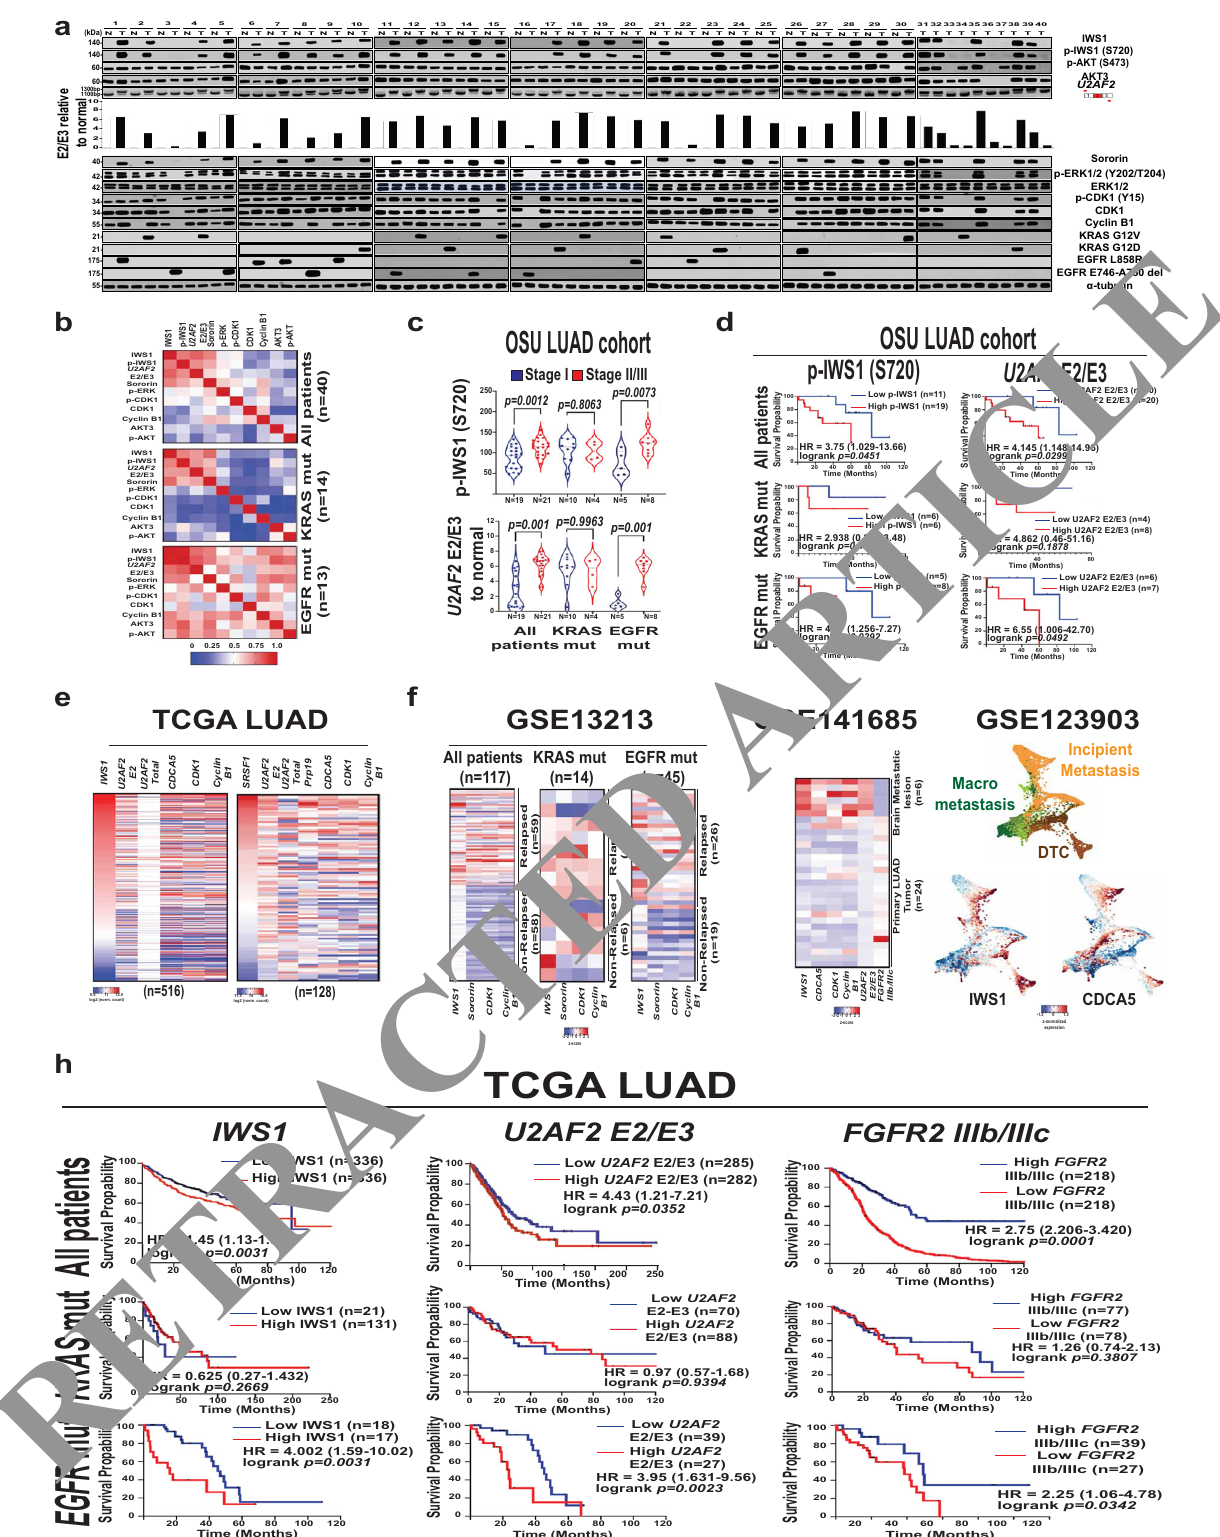
(Fig. 8g, Supplementary Fig. 12k). Importantly, the U2AF2 E2/E3 ratio was also higher in the metastatic tumors, while the IIIb/IIIc FGFR2 transcript ratio was reduced (Supplementary Fig. 12l), in agreement with our earlier observations, showing that IWS1 phosphorylation promotes FGFR2 exon 8 skipping 22 . The role